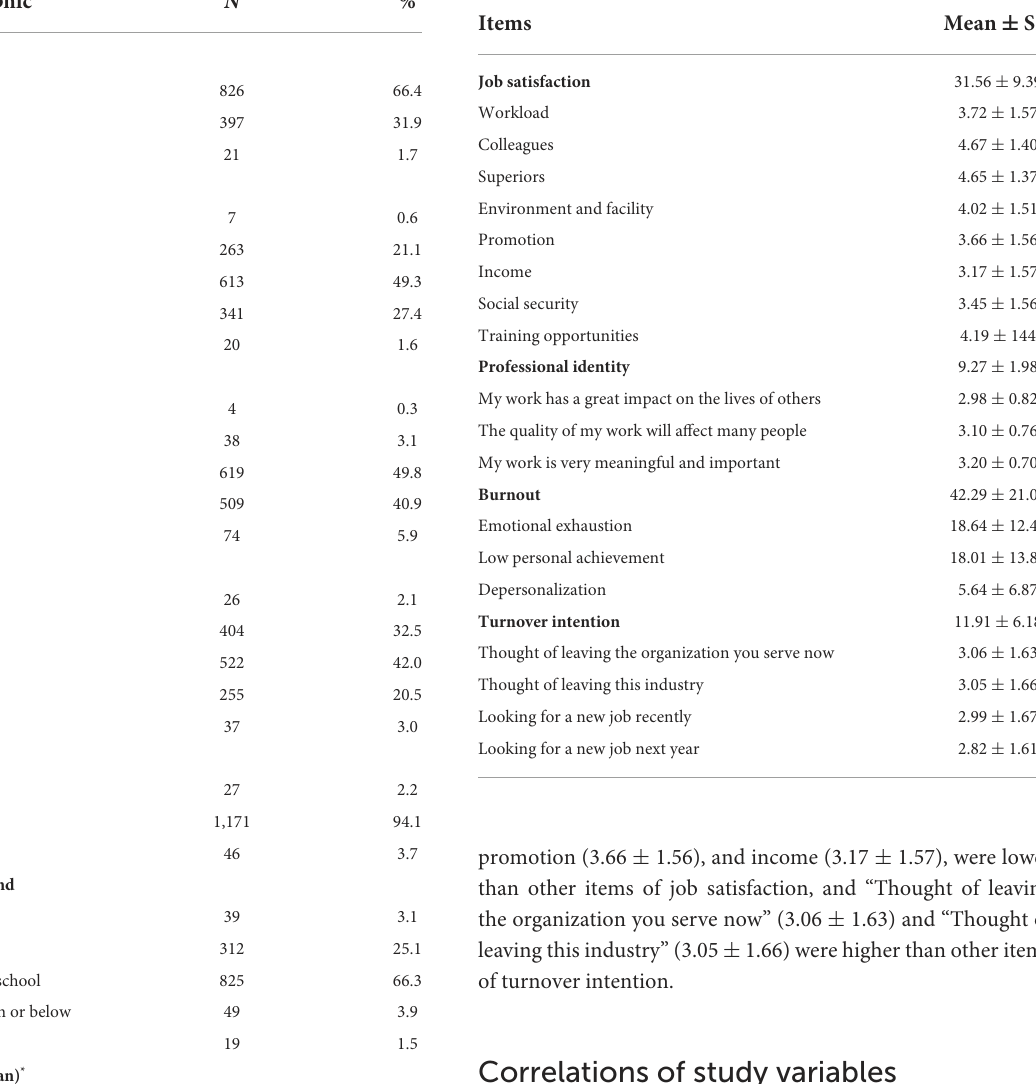
TABLE 3 Demographic characteristics of participants ( n = 1,244). TABLE 4 Item scores in job satisfaction, professional identity, job